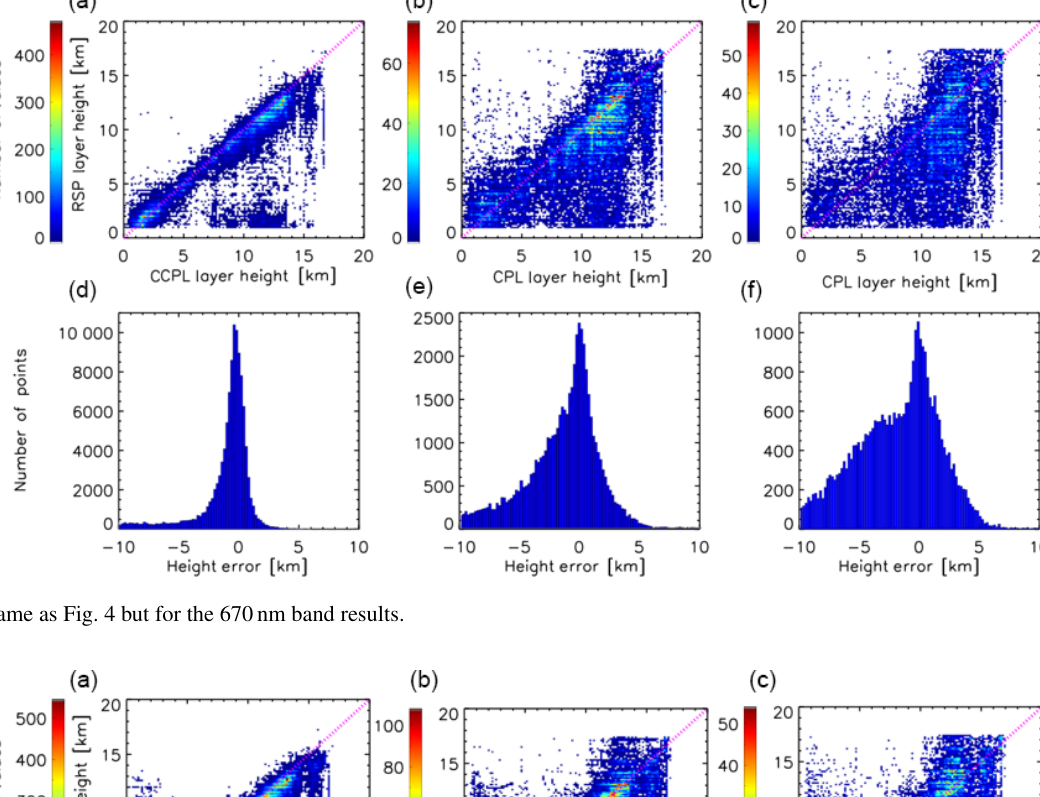
Figure 5. Same as Fig. 4 but for the 670nm band results.